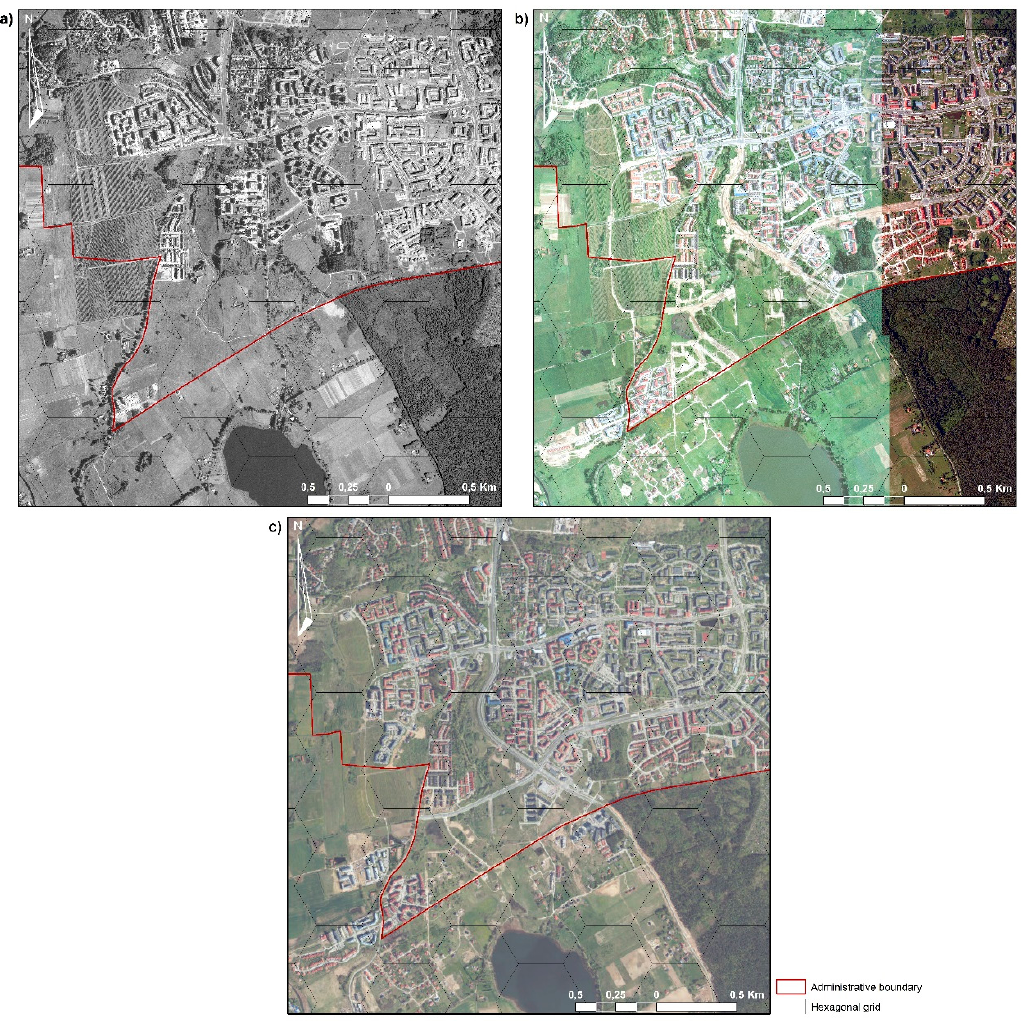
Figure 3. Fragments of the studied area divided into hexagonal fields: ( a ) 2005; ( b ) 2010; ( c ) 2017.